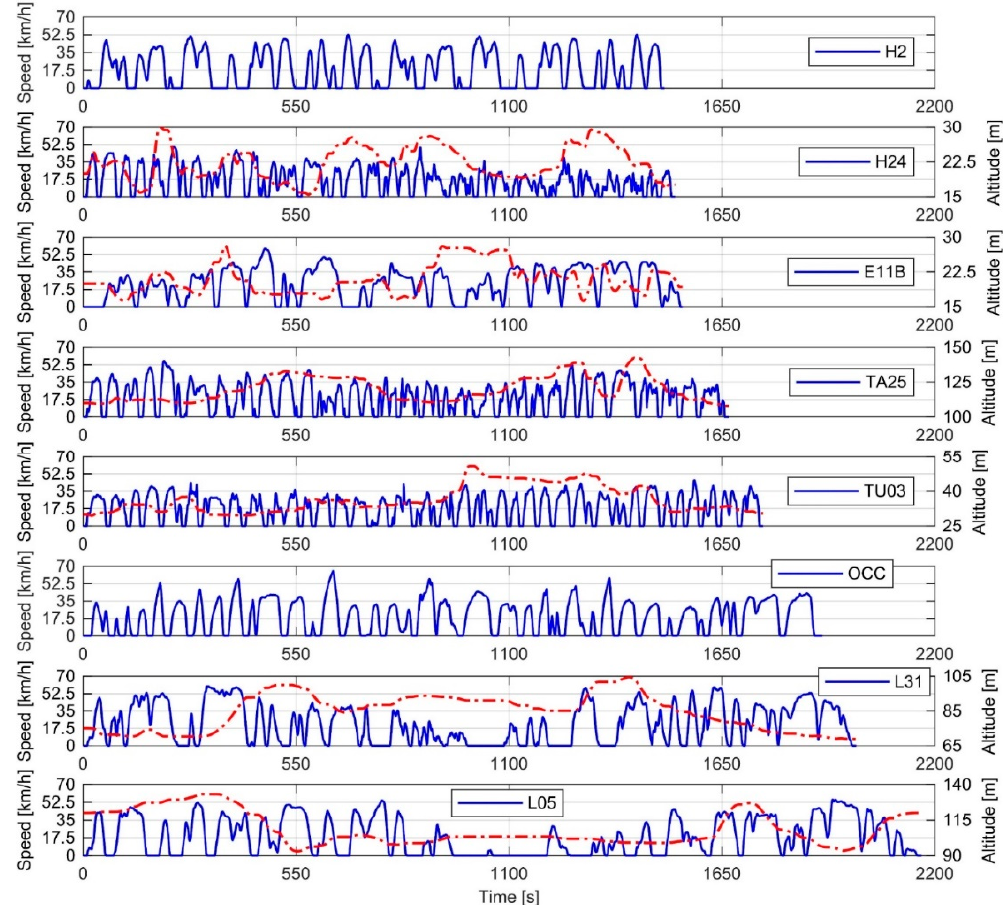
Figure A2. City bus driving cycles with a maximum duration of 2200 s.